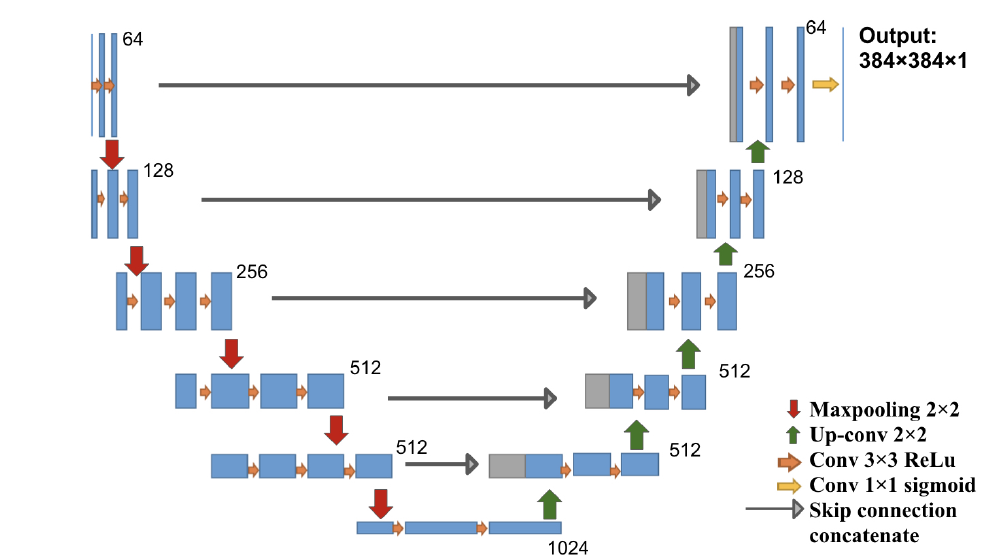
Figure 1. U-Net architecture: each block in the down-sampling path consists of convolution and max pooling operations, and each block in the up-sampling path consists of up-convolution and convolution operations. Each blue box corresponds to a multi-channel feature map. The number of features at the end of each block is denoted on top of the box. Arrows of different colors denote the different